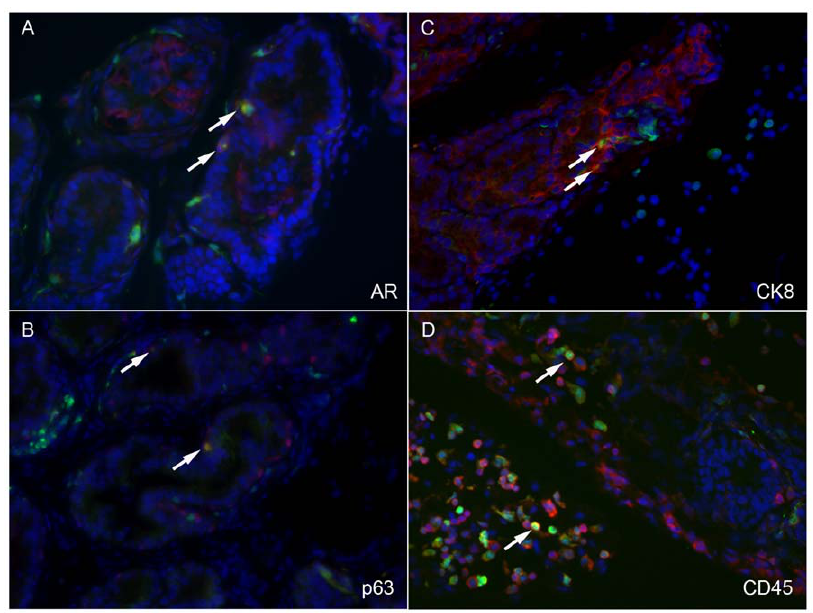
Figure 2. BMDCs incorporated into the prostate during regrowth. Immunofluorescence staining localized GFP-BMDCs (green) with prostate- specific markers (red). DAPI stained the nuclei (blue). A) Androgen receptor, B) p63, and C) cytokeratin 8 were expressed in recruited GFP-BMDCs. D) GFP-BMDCs had minimal co-expression of the hematopoietic marker, CD45.